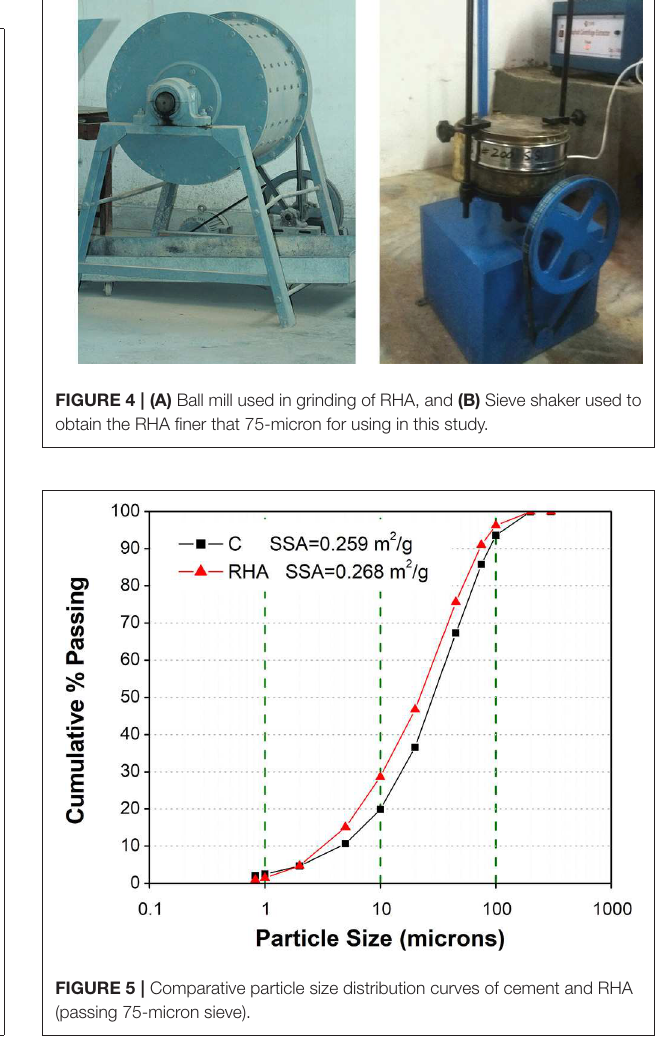
FIGURE 3 | XRD pattern of RHA treated at temperature (A) 700 ◦ C, (B) 950 ◦ C.